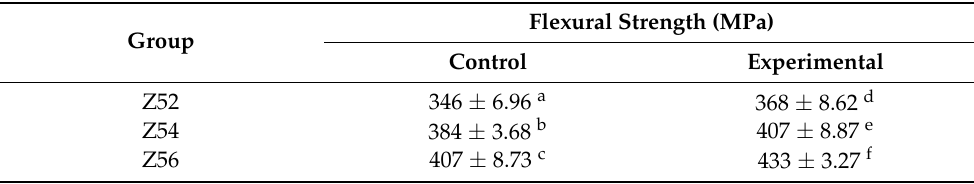
Table 5. Vickers hardness of printed zirconia; different letters represent significant differences ( p <